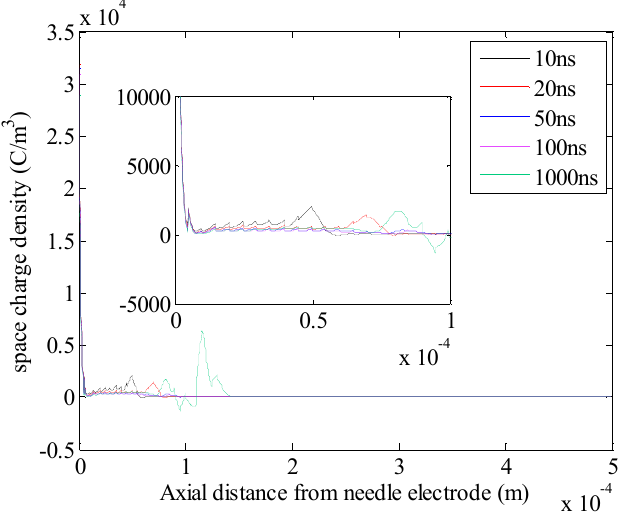
Figure 12. Space charge density distribution along the needle-sphere axis as a response to 1.5 PDIV with 10 mm needle-sphere electrode